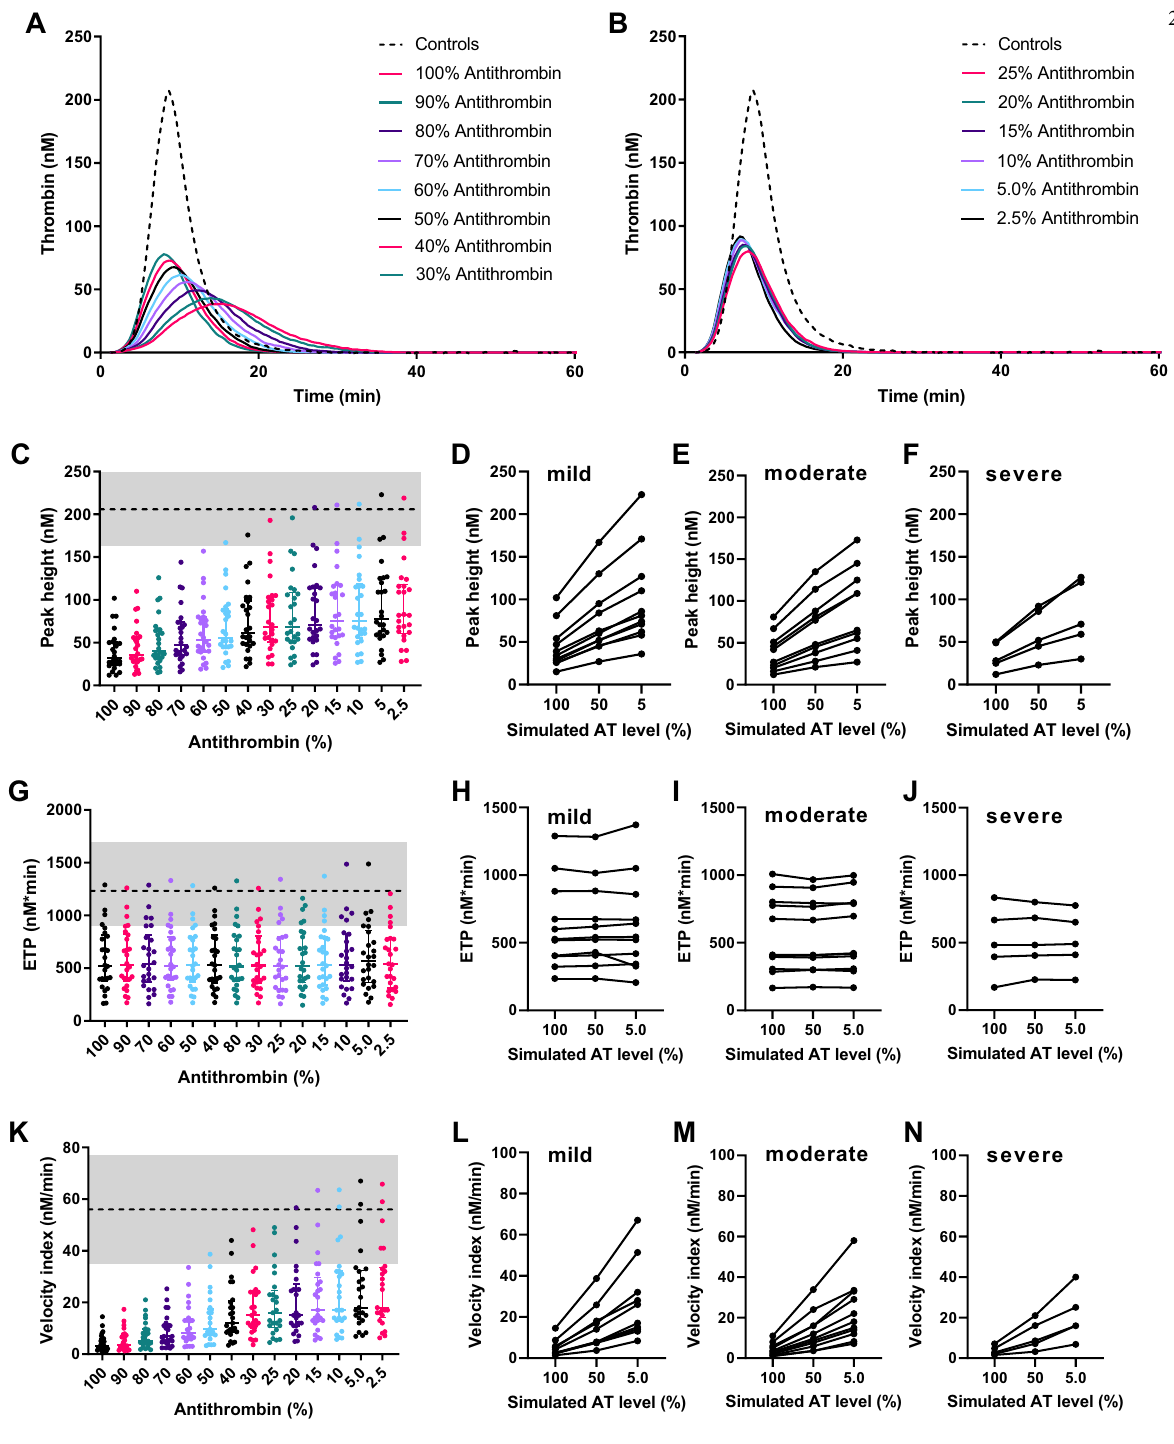
Figure 5. The in silico effect of antithrombin targeting in haemophilia on thrombin generation. ( A ) The average TG curve of the haemophilia A patients at the original plasma AT level (100%) in silico generated average thrombin generation curves of the same patients at 90, 80, 70, 60, 50, 40, and 30% AT. ( B ) The average in silico generated average thrombin generation curves of the haemophilia A patients at 25, 20, 15, 10, 5, and 2.5% AT. The generated TG curves were quantified by their peak height ( B – F ), ETP ( G – J ) and velocity index ( K – N ). References ranges in the healthy subject group are plotted as grey box with the mean value in healthy subjects indicated as a dashed line. The effect AT reduction to 50% and 5% of the original plasma level is depicted for the peak height for mild ( D ), moderate ( E ) and severe ( F ) haemophilia A patients, and the same is shown for the ETP ( H – J ) and the velocity index ( L – N